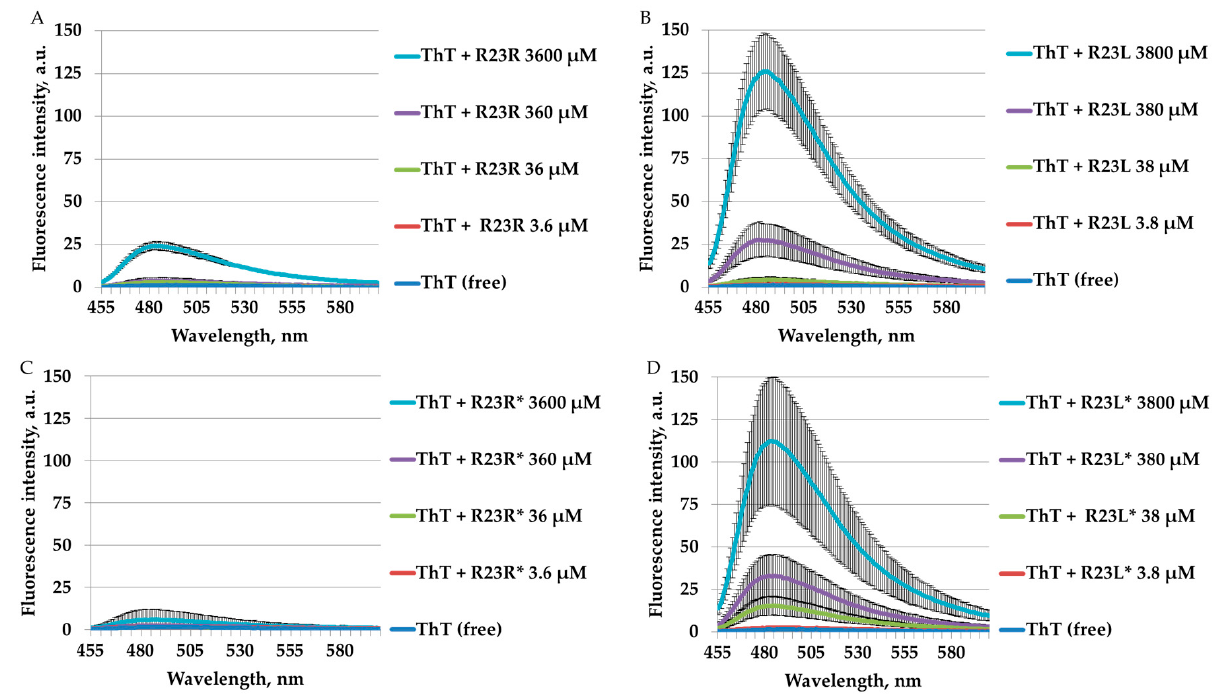
Figure 6. Spectra of fluorescence intensity of free thioflavin T (ThT) and in solution with individual peptides R23R ( A ), R23L ( B ), R23R* ( C ), and R23L* ( D ) under conditions of 50 mM TrisHCl, 150 mM NaCl, pH 7.5, 20% (volume/volume) DMSO after 24 h at 37 °C. Error bars with standard deviations for the mean values of the measured fluorescence intensity are shown.